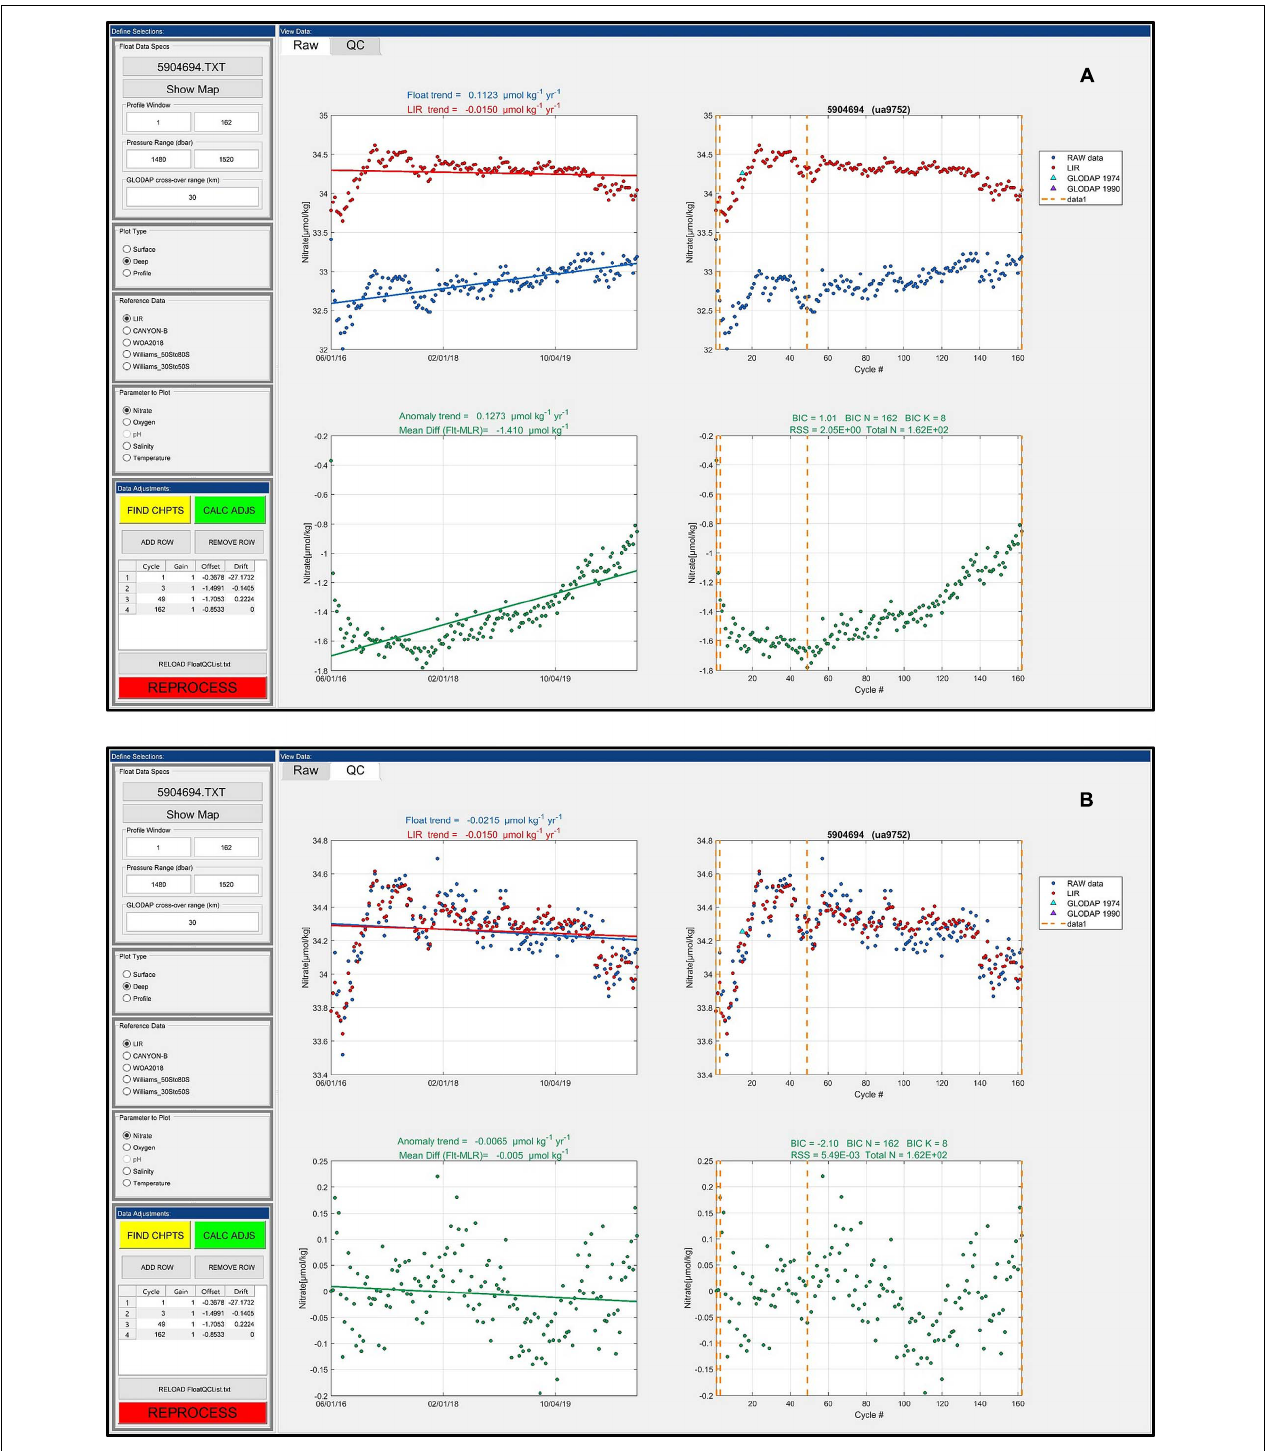
FIGURE 6 | SAGE software interface showing nitrate data (blue) from MBARI/UW float 9752 (WMO 5904694) against the selected “LIR” reference (red) and the resulting float minus reference anomaly time series (green). The view in (A) displays the raw nitrate float data; the view in (B) displays nitrate data that has been adjusted using coefficients derived through the